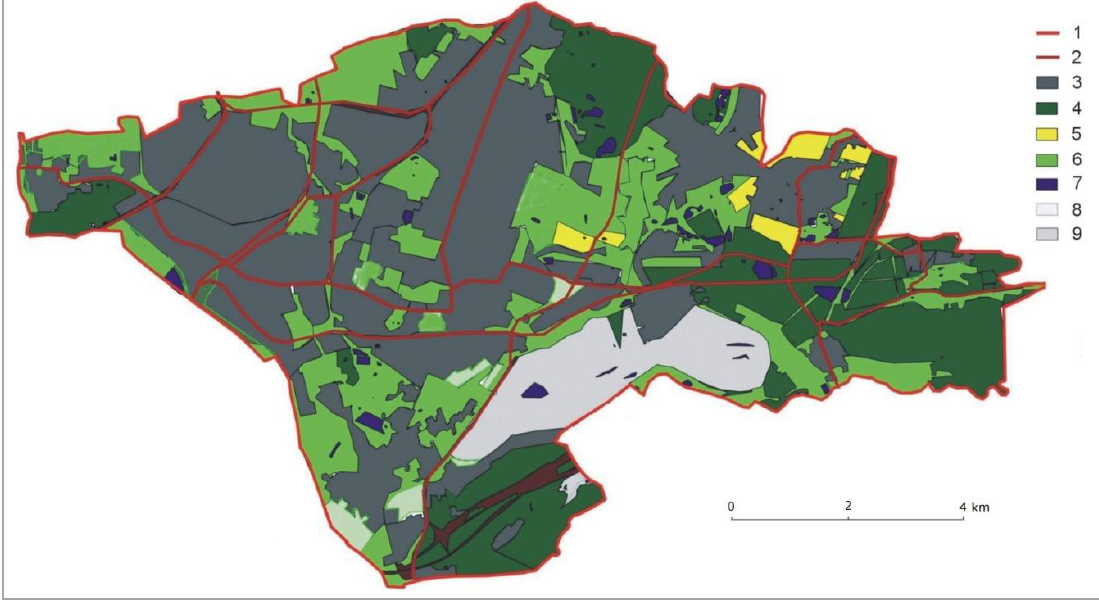
Fig. 2. Spatial structure of Sosnowiec (based on Plan zagospodarowania …,